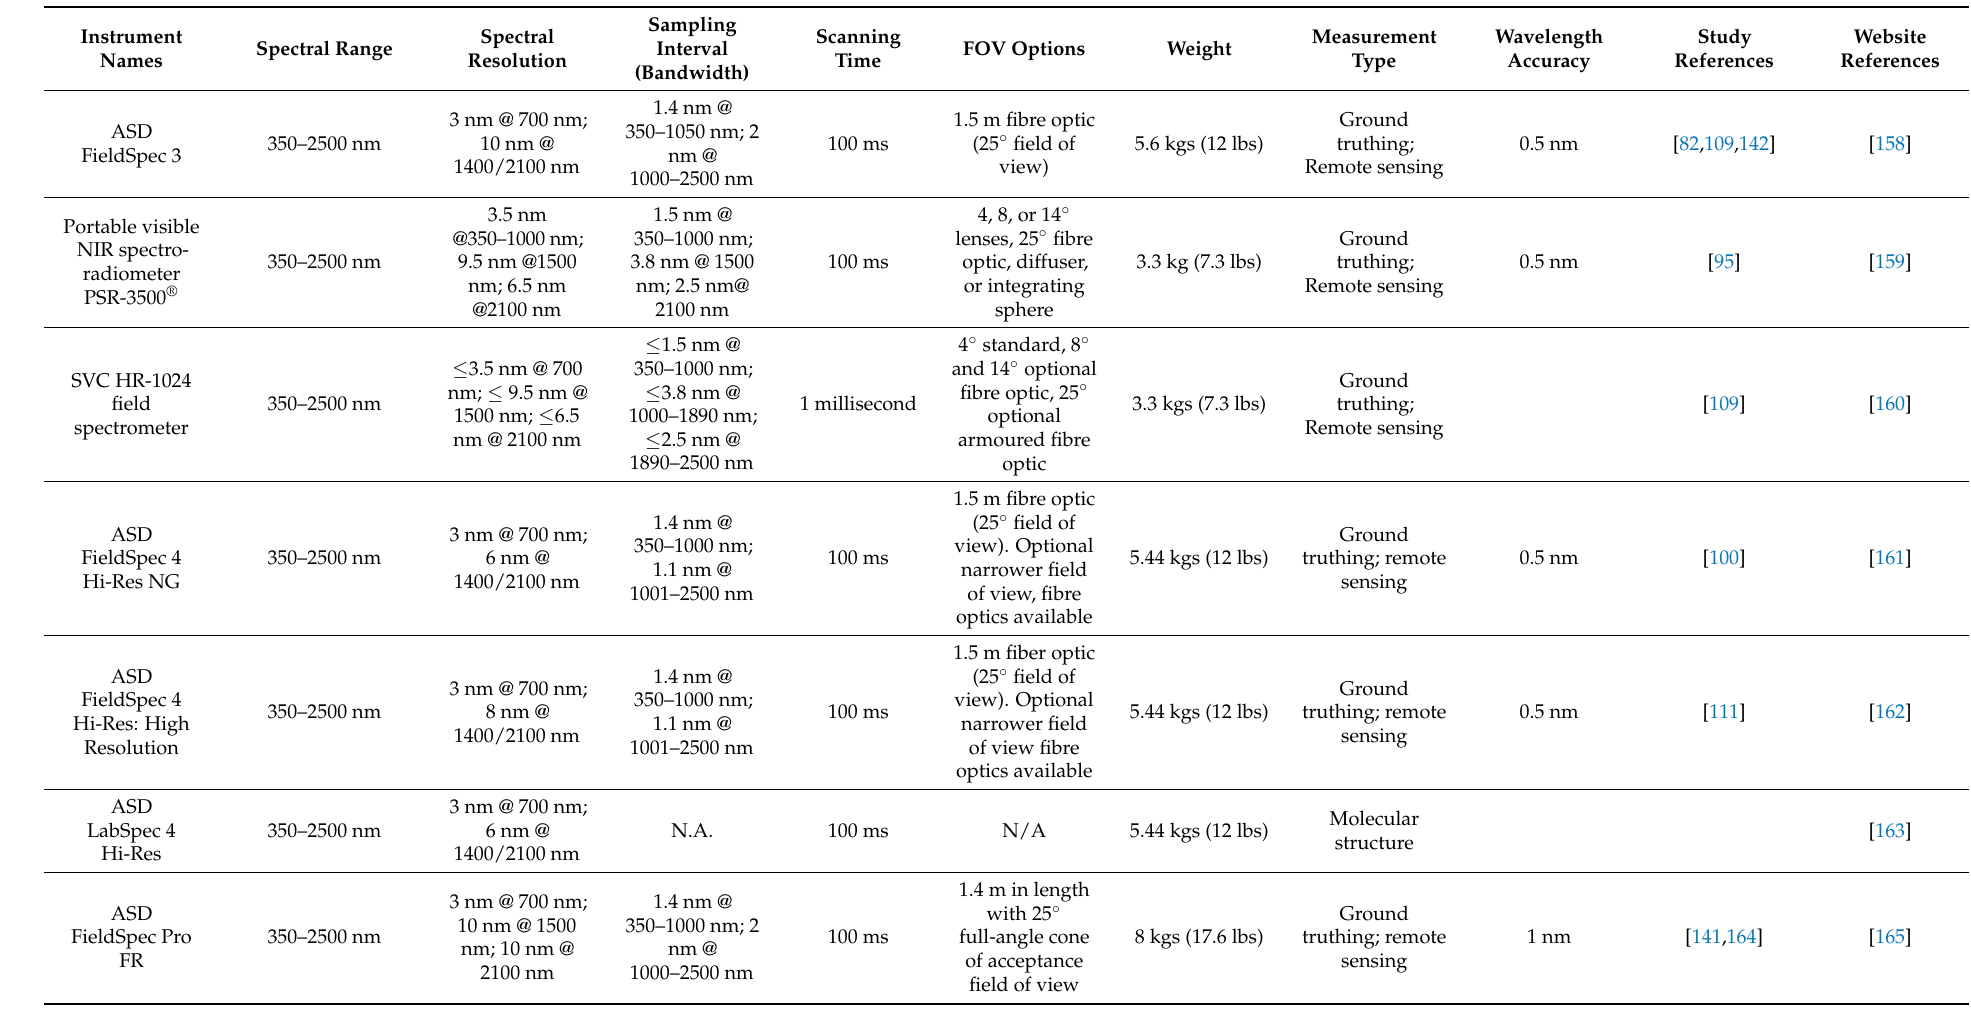
Table 6. Different types of spectrometer instruments for collecting